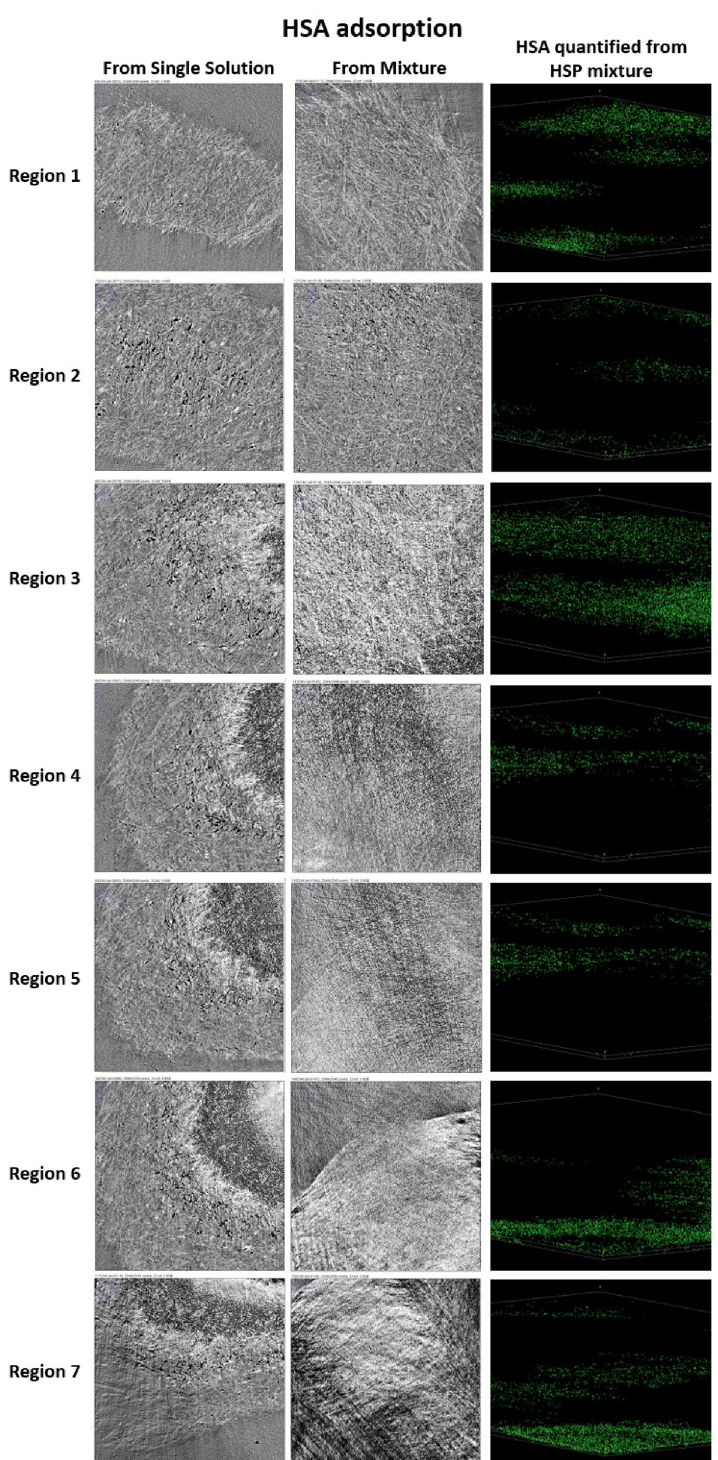
Figure 6. Converted radiographs of the PES membrane with adsorbed HSA from its single solution and HSP, and visualization of the HSA distribution across the membrane